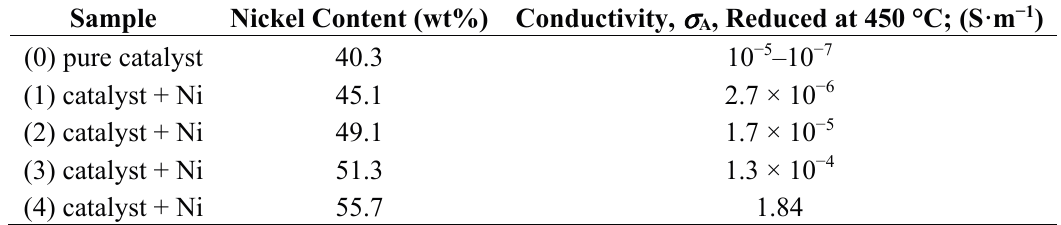
Table 3. Results of the commercial nickel catalyst with additional nickel